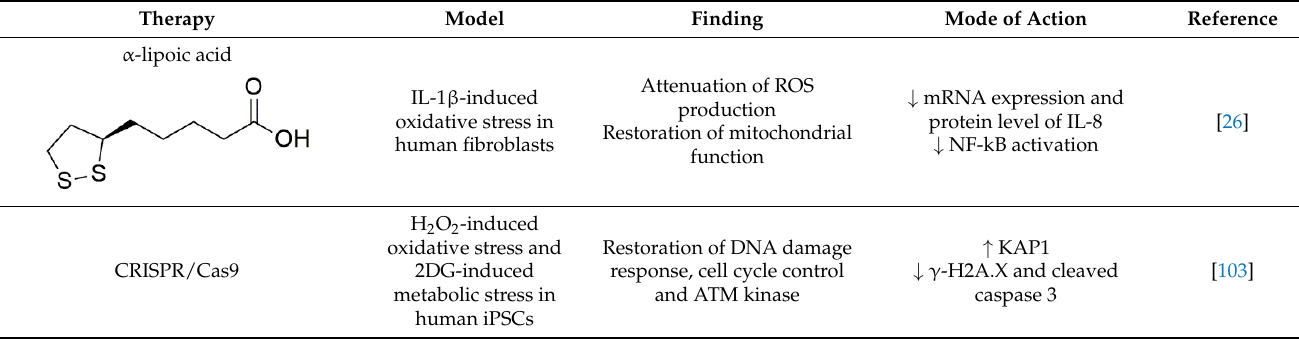
Table 1. Antioxidant therapies in the management of ataxia-telangiectasia.